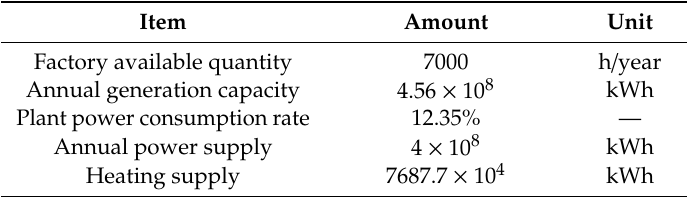
Table 1. Cogeneration power and energy output of the